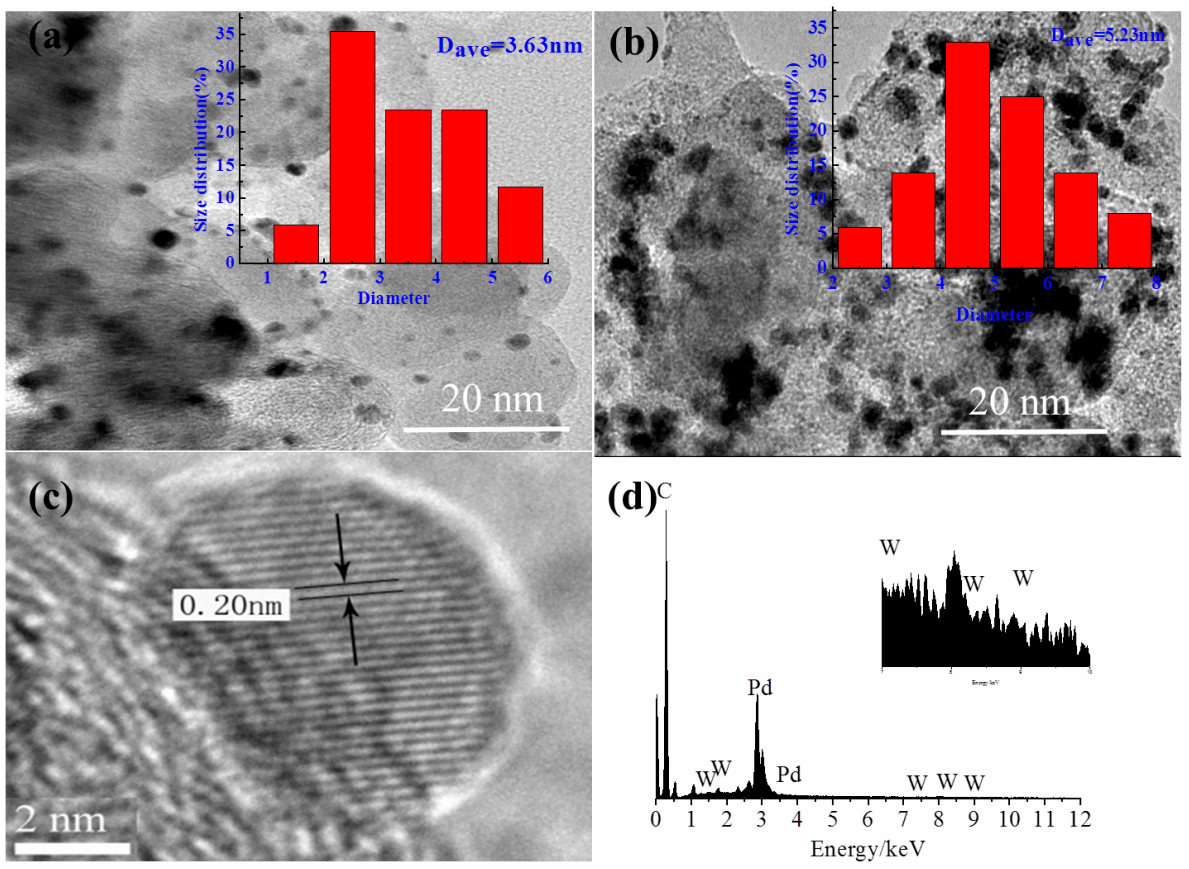
Figure 1. TEM images and their corresponding particle size distribution histograms ( a ) PdW/C; ( b ) Pd/C catalyst, respectively. ( c ) HRTEM images of PdW/C catalyst. ( d ) EDS of PdW/C